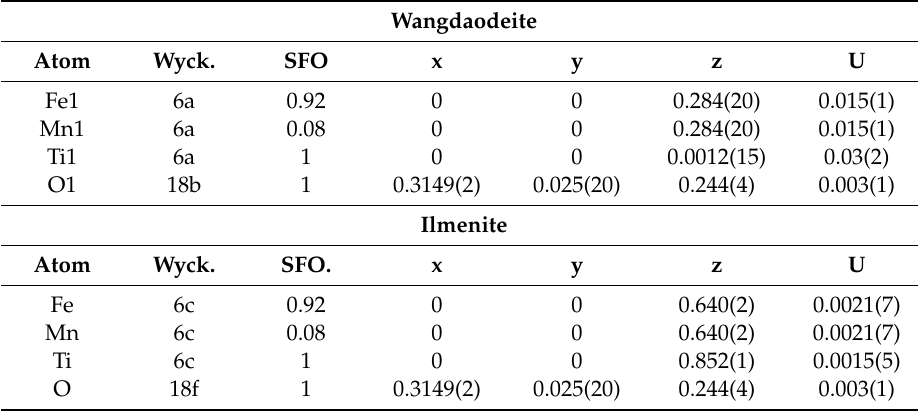
Table 1. Fractional atom coordinates, site fraction occupancies, and isotropic thermal displacement factors of wangdaodeite and recrystallized ilmenite from Ries xenolith ZLN114. The site fractional occupancies were fixed according to the chemical analysis. SFO = site fractional occupancy, Wyck. = Wycko ff site. Isotropic U in Å 2 .